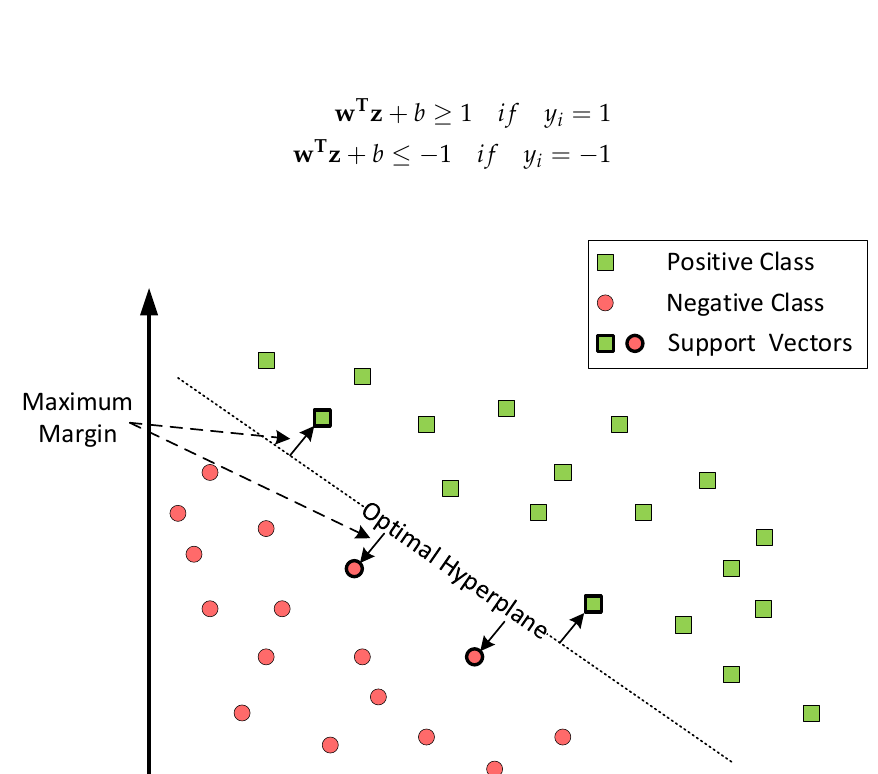
Figure 3. SVM binary